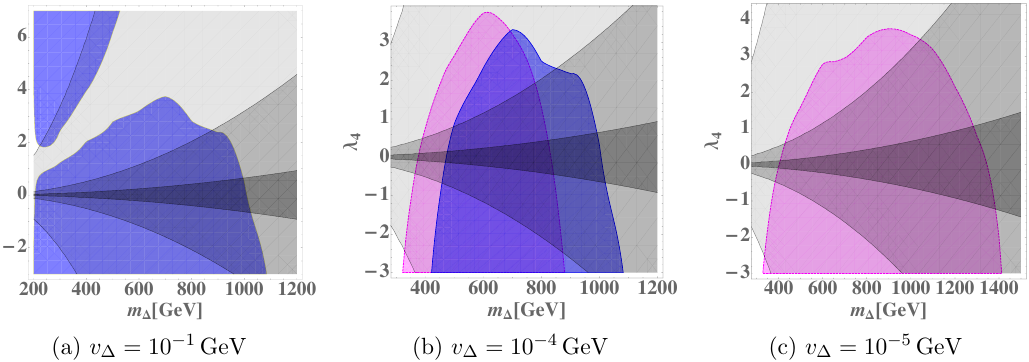
Figure 11 . Blue is signi(cid:12)cance (cid:21) 5 region for the hW (cid:7) W (cid:6) W (cid:6) channel and magenta is that for the hW (cid:7) ‘ (cid:6) ‘ (cid:6) channel. The outermost very light black region is the combined constraint on R h(cid:13)(cid:13) from ATLAS and CMS at 7 TeV and 8 TeV; the intermediate light black region is the planned FCC-ee constraint and the innermost black region is the planned FCC-ee+FCC-hh constraint on R h(cid:13)(cid:13) . corner is due to an increase of the decay BR for H (cid:6) ! hW (cid:6) when (cid:21) to positive as can be seen from the upper right panel of (cid:12)gure 4. Therefore, at large v the W (cid:6) W (cid:6) hW (cid:7) channel is more helpful for the determination of (cid:21) From (cid:12)gure 11(b), i.e., corresponding to intermediate v